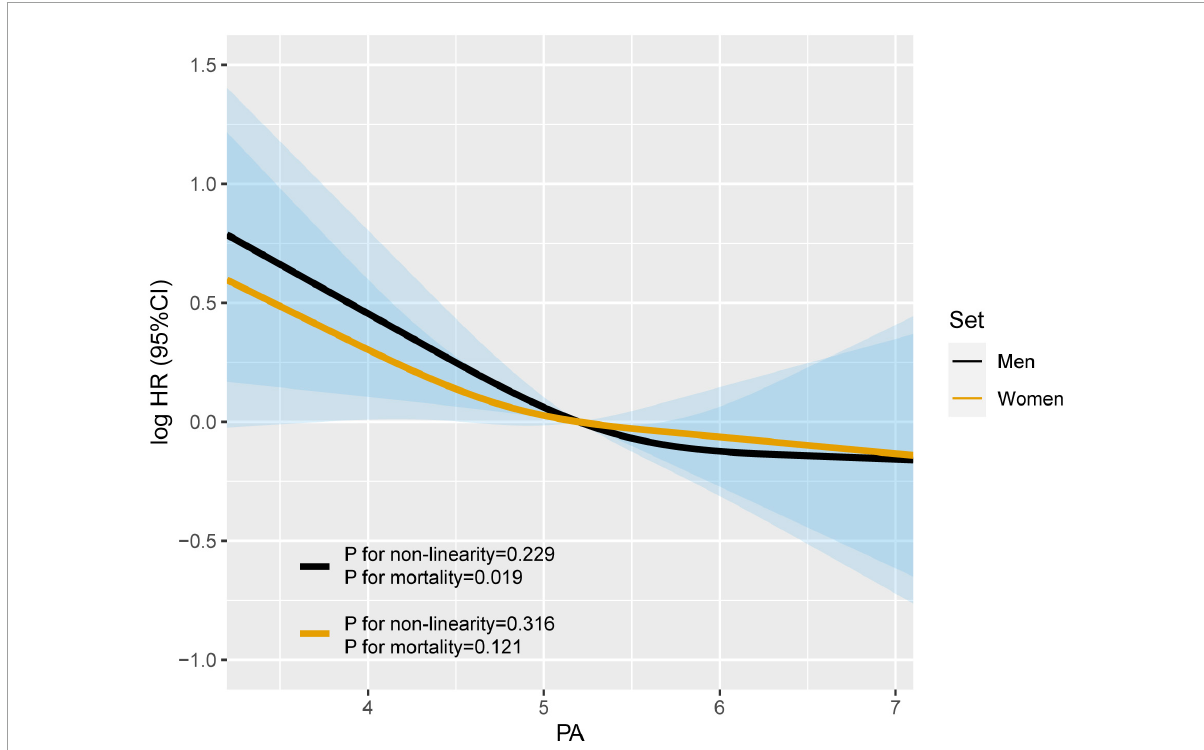
FIGURE1 The sex differences in the association of phase angle (PA) and all-cause mortality in patients with lung cancer. Model c: Adjusted for age, TNM stage, BMI, smoking, alcohol drinking, diabetes mellitus, hypertension, coronary heart disease, chemotherapy, radiotherapy, and surgery.